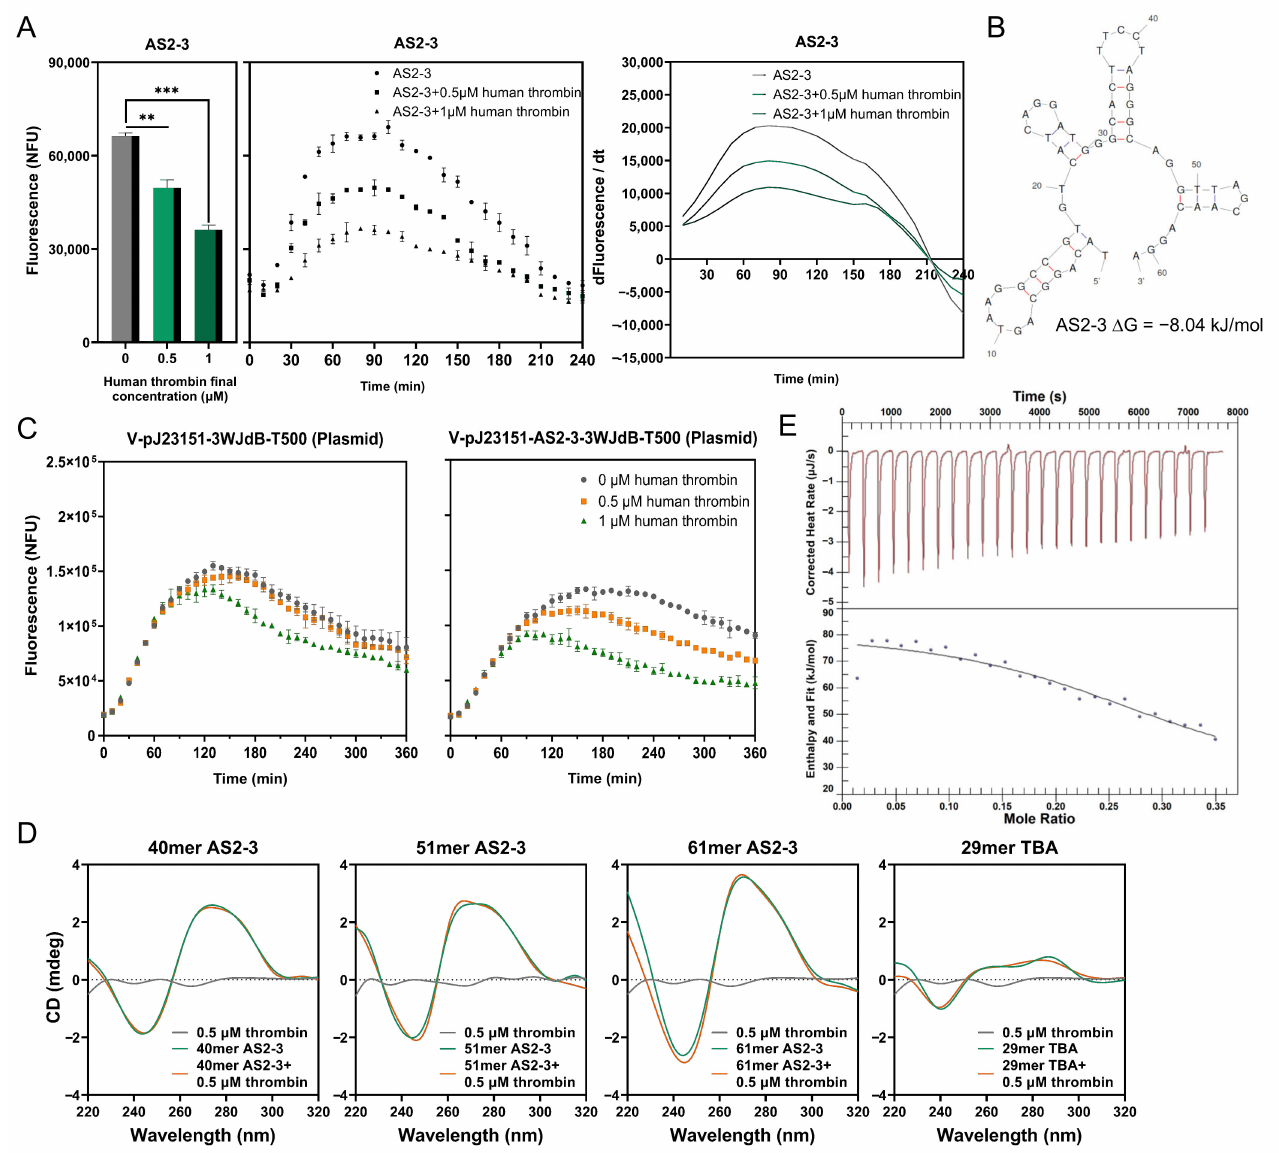
Figure 2. ( A ) Fluorescence peaks, real-time fluorescence, and rates of fluorescence changes of AS2-3 before and after adding different concentrations of human thrombin. n = 3 biological replicates, Dunnett- t test; ** p < 0.01, and *** p < 0.001; bars represent mean ± S.D. ( B ) Predicted secondary structure of aptamer AS2-3 using RNA folding software. ( C ) Real-time fluorescence of the control plasmid and J23151-AS2-3-3WJdB plasmid in the cell-free transcription reaction in response to the addition of 0.5/1 µ M human thrombin; the final DNA concentrations were 50 nM, the reaction temperature was 29 ◦ C, and the reaction time was 6 h. ( D ) CD spectra of aptamer candidates AS2-3, and 29mer TBA. ssDNA (green curve), 0.5 µ M human thrombin and ssDNA complex (orange curve), and 0.5 µ M human thrombin (gray curve) are shown. ( E ) ITC was used to measure the K d of the candidate aptamer